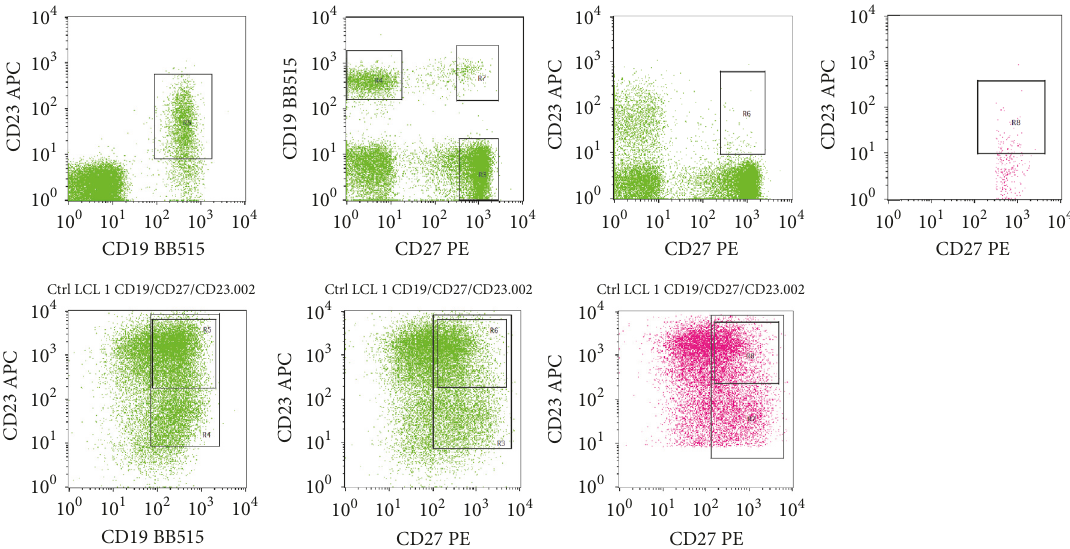
Figure 4: CD23 and CD27 expression analysis of CD19 + B-cells by flow cytometry. The upper panel shows the analysis of PBMCs isolated from patient 8A while the lower panel shows the analysis of the corresponding LCLs (LCL-8A). R3 : gated CD27 + cells; R4 : gated CD19 + B-cells; R5 : gated CD19 + CD23 + ; R6 : gated CD23 + CD27 + cells; R7 : gated CD19 + CD27 + cells; R8 : gated CD19 + CD23 + CD27 +